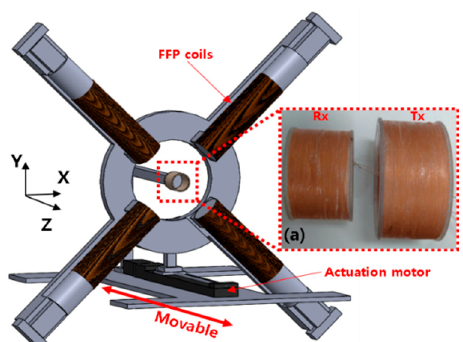
Figure 1. The configuration of the proposed movable system for magnetic particle imaging (MPI) based on four coils. The mainframe of the system can be moved one-dimensionally by the actuation motor to scan the Z-axis. ( a ) To receive the signals reflected by the particles, a combined coil comprising a transmitting coil and a receiver coil was installed at the center of the region of interest (ROI).